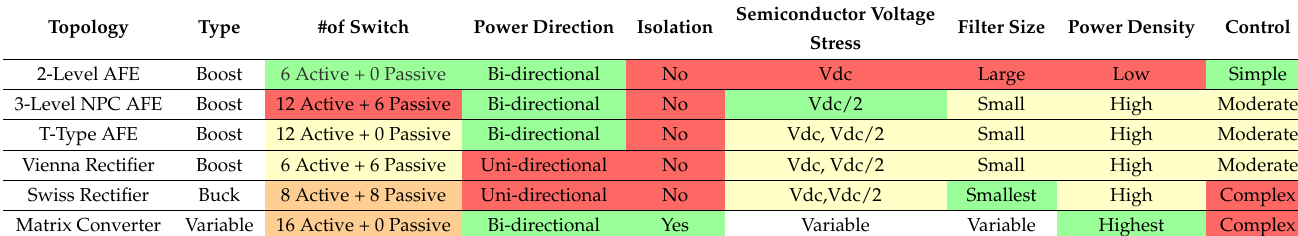
Table 2. Comparison of AC/DC Topologies. The excelling topology for the specific feature is colored green: best, red: